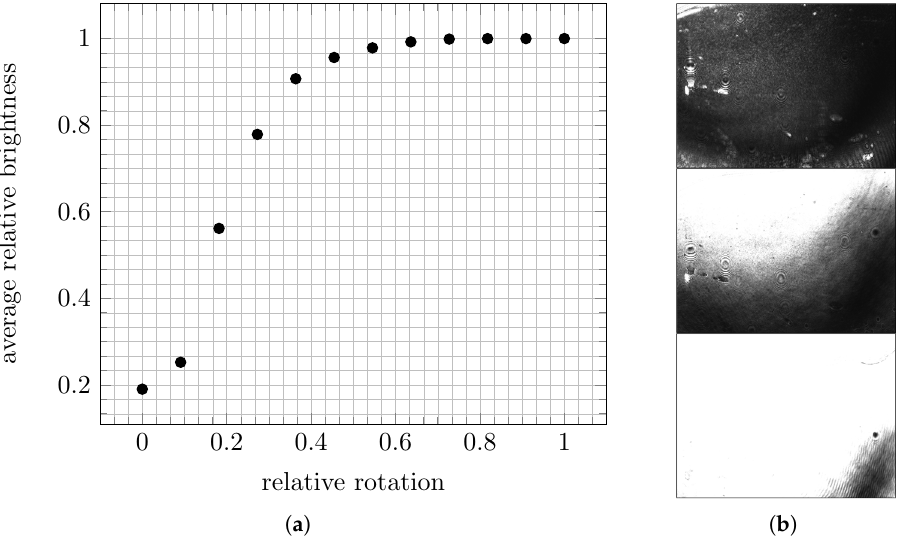
Figure 15. Plot ( a ) shows the average intensity of the recorded images while rotating the prism to different angles, and three examples ( b ) of raw images recorded at positions 0.0 (top), 0.18 (middle), and 0.45 (bottom). The angles are given relative to the maximum of the possible interval.